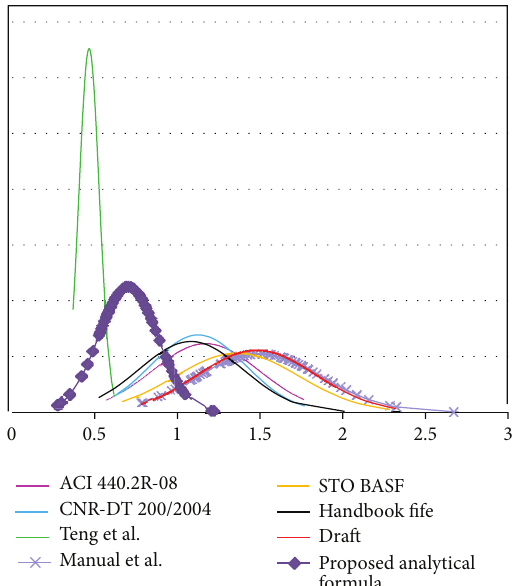
Figure 2: Normal distributions for 𝑥 1 .